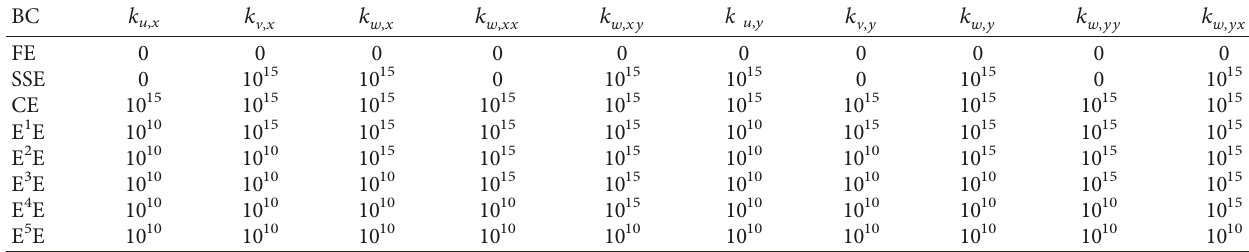
Table 1: Spring stiffness values correspond to different boundary conditions.